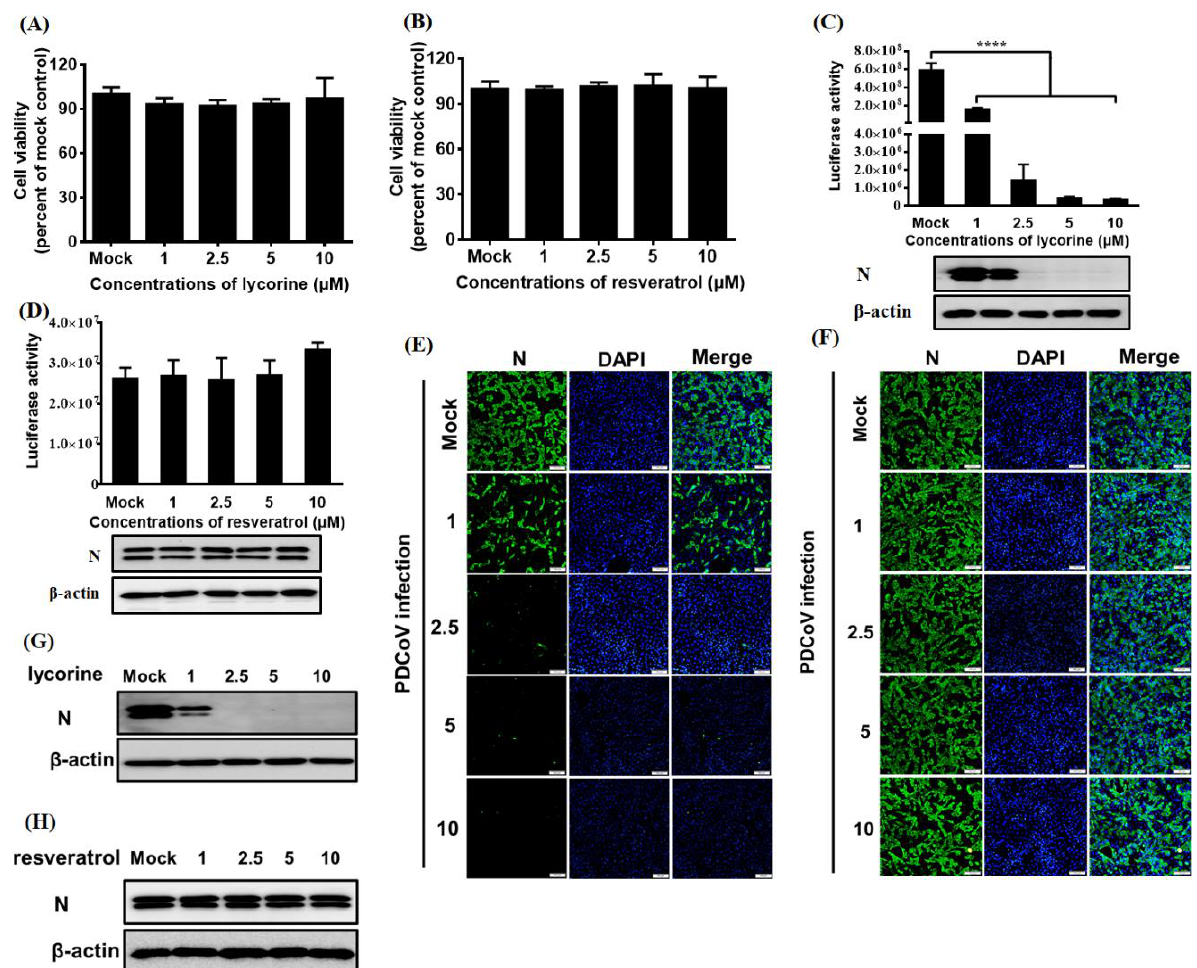
Figure 6. Application of Nluc reporter virus in drugs screening. ( A , B ) CCK-8-based cell viability assay for lycorine ( A ) and resveratrol ( B ) as described in materials and methods. ( C , D ) The effect of the lycorine ( C ) and resveratrol ( D ) on Nluc reporter virus infection by luciferase activity detection and Western blot analysis. LLC-PK1 cells were pretreated with various concentration of lycorine and resveratrol for 1 h and then infected with Nluc reporter virus for 12 h. Cell lysates were collected and subjected to the measurement of luciferase activity and Western blot assay using antibodies against N and β -actin. **** p < 0.0001. ( E , F ) The effect of the lycorine ( E ) and resveratrol ( F ) on Nluc reporter virus infection by IFA. LLC-PK1 cells were pretreated with various concentration of lycorine and resveratrol for 1 h and infected with Nluc reporter virus for 12 h, followed by IFA using anti-PDCoV N antibody. Bar, 100 µ m. ( G , H ) The effect of the lycorine ( G ) and resveratrol ( H ) on wild type PDCoV CHN-HN-2014 infection by Western blot. LLC-PK1 cells were pretreated with various concentration of lycorine and resveratrol as described in panel E and F, and infected with CHN-HN-2014 for 12 h, followed by western blot using anti- PDCoV N and β -actin antibody, respectively.